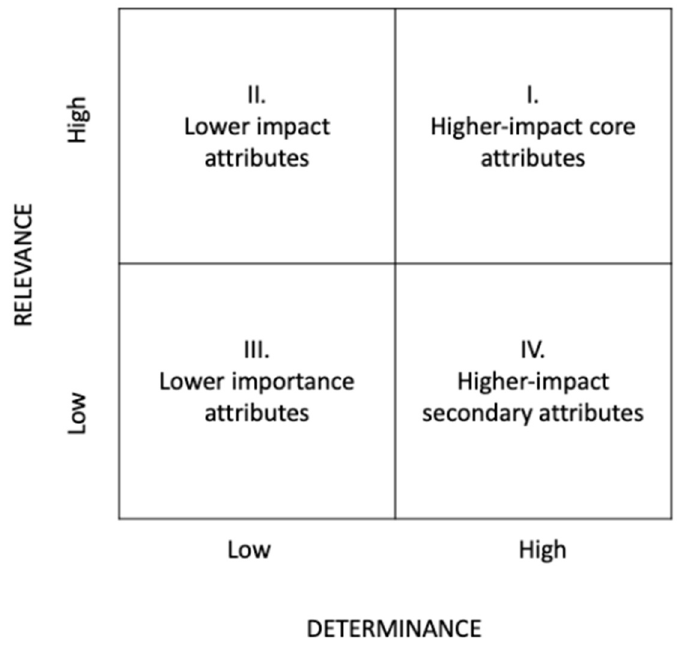
Figure 2. Relevance-determinance analysis (RDA) matrix [24].